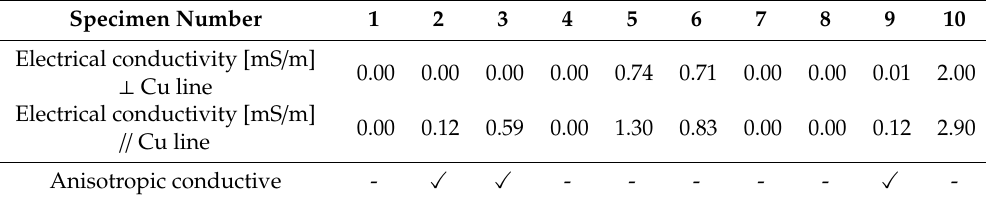
Table 4. Evaluation of anisotropic conductivity for SS-processed Cu / PET